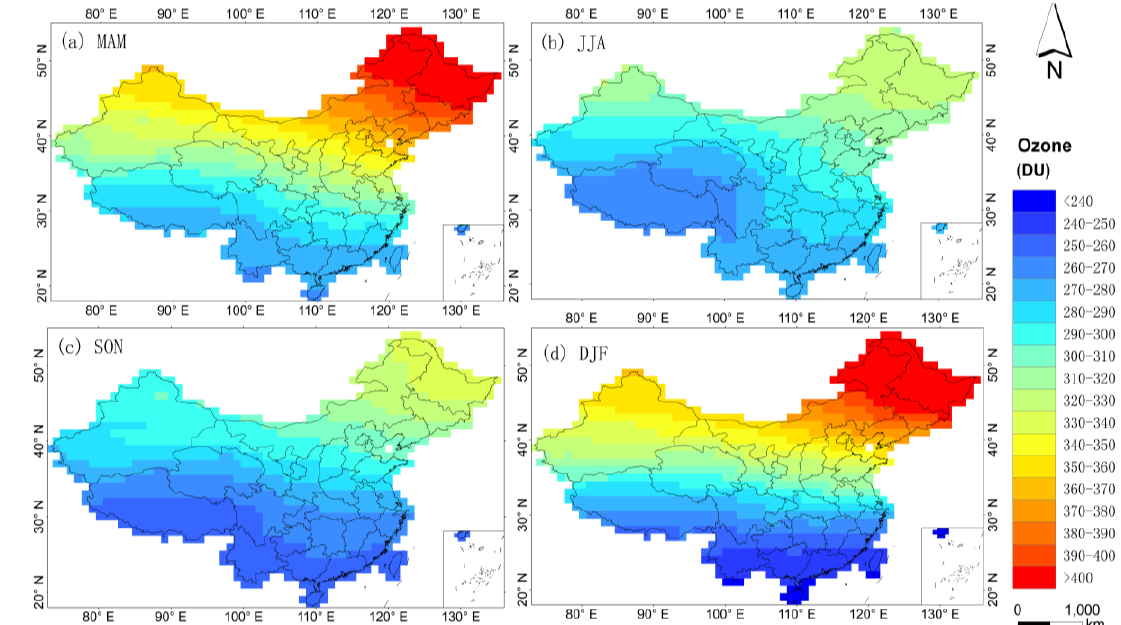
Figure 5. Seasonal variation of total ozone column over China from 2005 to